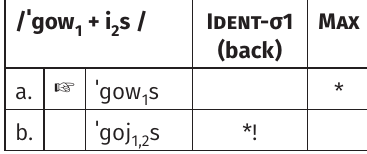
Table 2: Monosyllabic [ˈɡow] protected from alternation.